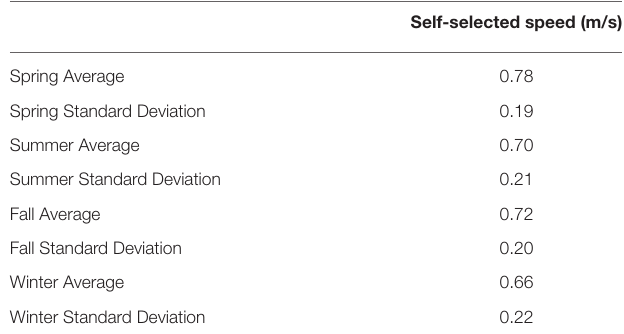
TABLE 2 | Self-selected speeds based on seasons of individuals’ data